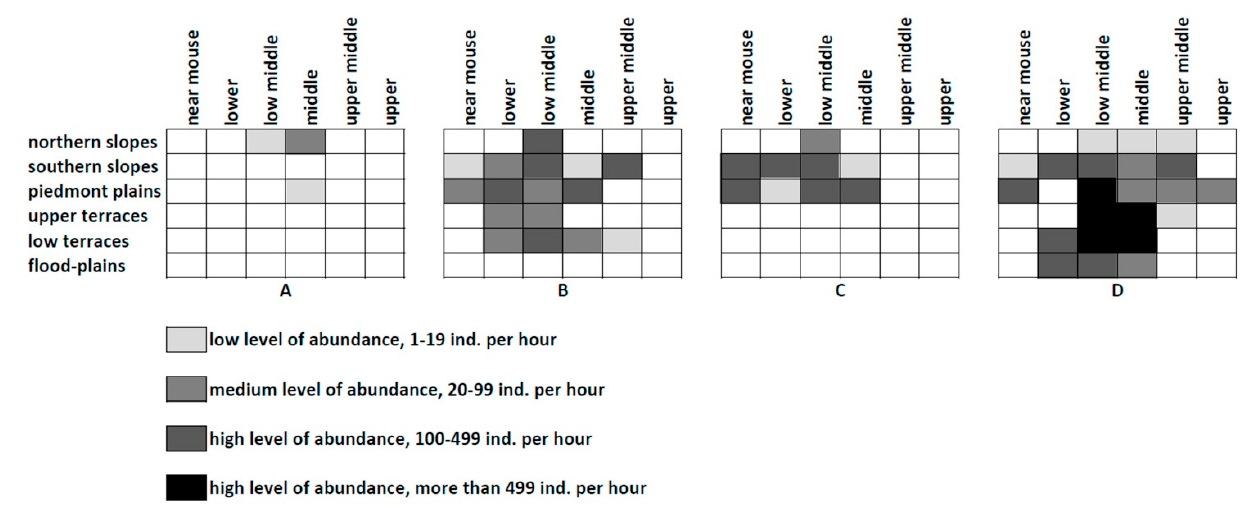
Figure 5. Population distribution of model orthopteran species across the basin of the small Edigan River (mountain steppes of the central part of the Altay Mountains). ( A )— Zubovskya koeppeni (Zubovsky); ( B )— Chorthippus hammarstroemi (Miram); ( C )— Stenobothrus eurasius Zubovsky; ( D )— Chorthippus parallelus (Zetterstedt).